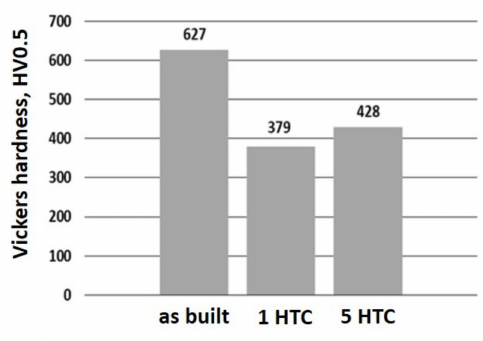
Figure 4. Vickers hardness of laser powder bed fusion (L-PBF) processed Fe-Mn-Al-Ni in the as-built condition, as well as after 1 and 5 HTCs.